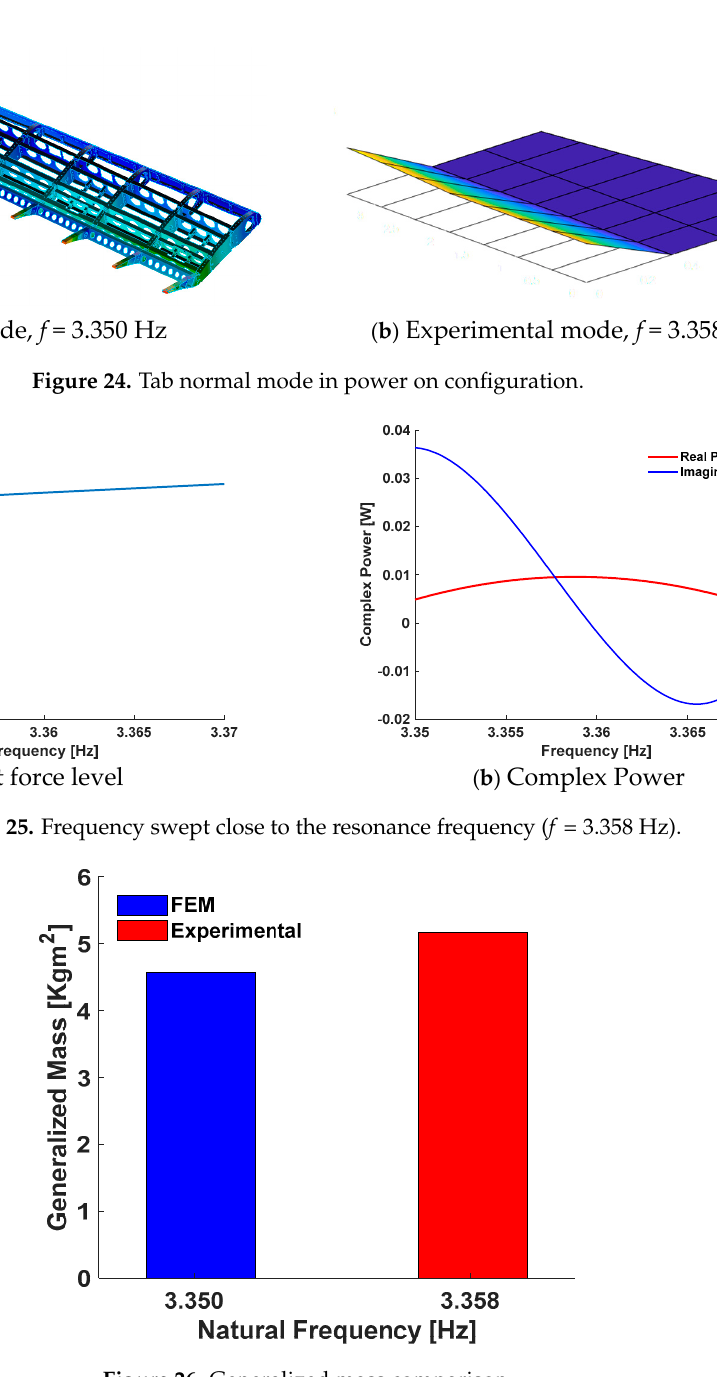
Figure 23. Boundary conditions of the GVT.